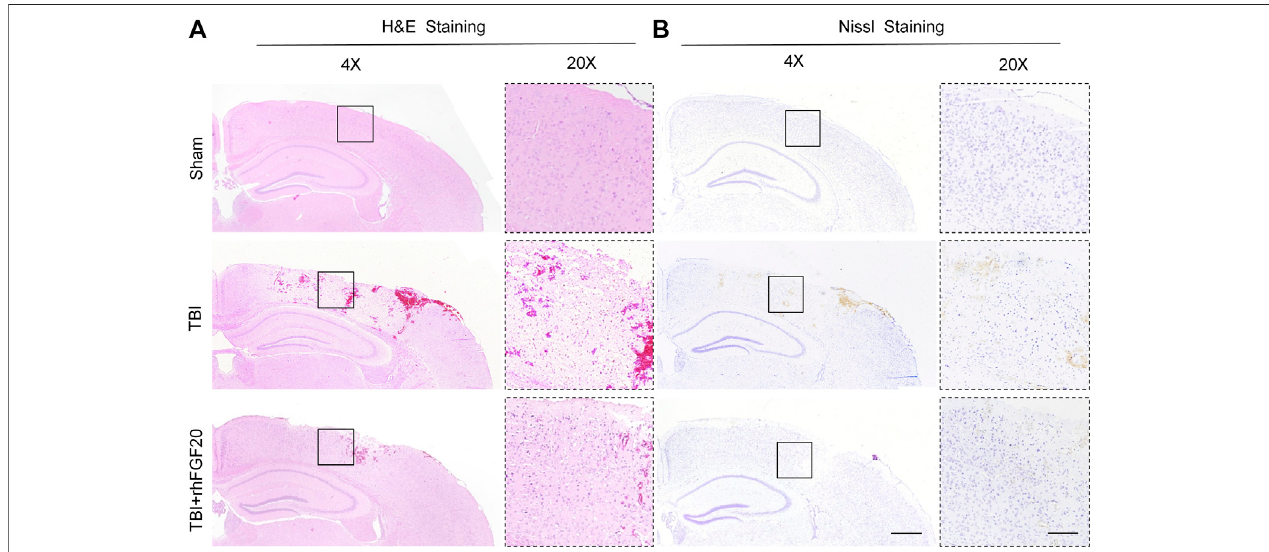
FIGURE2| ExogenousrhFGF20enhancesbraintissuesurvivalinTBImice (A) EffectsofrhFGF20ondamagedbraintissueafterTBI,asvisualizedbyH&Estaining (B) Effects of rhFGF20 on neurons in the brain after TBI, as demonstrated by Nissl staining. 4 × : Bar, 500 μ m. 20 × : Bar, 100 μ m ( n (cid:1) 4).